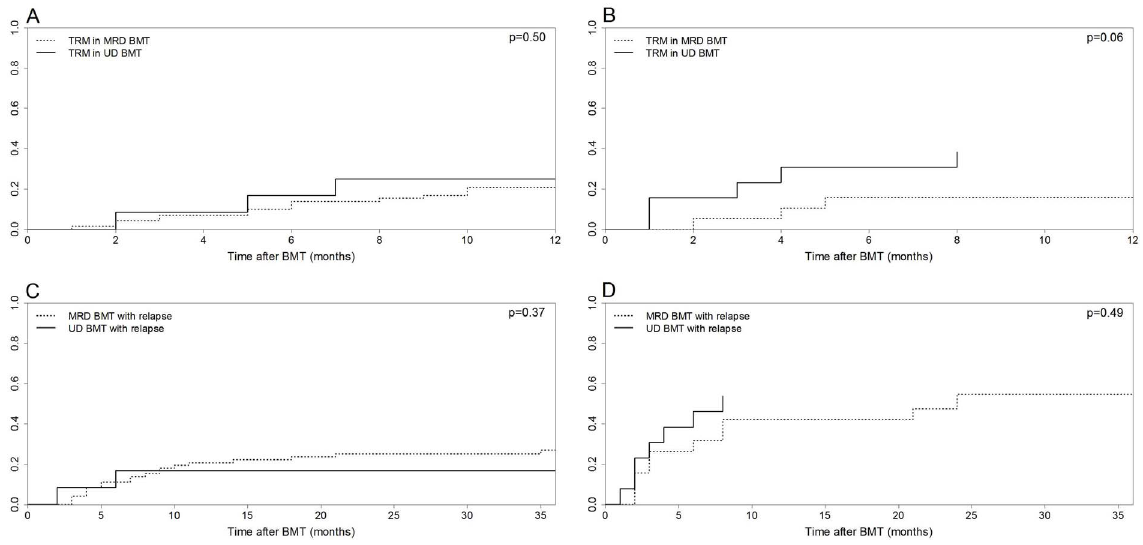
Figure 3. Cumulative incidence curves for matched related donor (MRD) and unrelated donor (UD) bone marrow transplantation (BMT). (A) Transplant-related mortality (TRM) in patients with non-advanced disease at the time of BMT. (B) TRM in patients with advanced disease at the time of BMT. (C) Relapse incidences in patients with non-advanced disease at the time of BMT. (D) Relapse incidences in patients with advanced disease at the time of BMT.